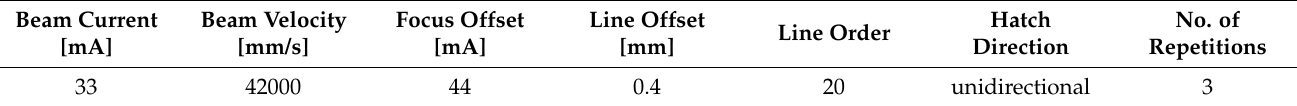
Table A1. Initial experiments (used the below parameters) conducted on Q20+ and SS 316L led to SS316L melting.